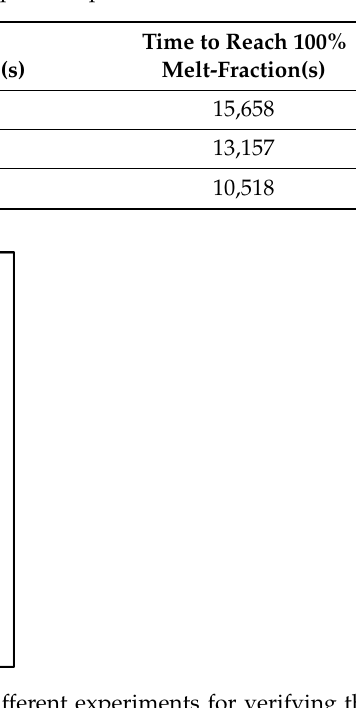
Figure 9. Comparison of temperature profiles in two different experiments for verifying the repeat- ability of the experiments: for the thermocouples mounted at the location corresponding to the height of the liquid meniscus for PCM melt-fraction of 60% and for heater input power of 1.6 W (2.8 V input). Figure 10. Comparison of temperature profiles in two different experiments for verifying the re- peatability of the experiments: for the thermocouples mounted at the location corresponding to the height of the liquid meniscus for PCM melt-fraction of 85% and for heater input power of 1.6 W (2.8 V input).